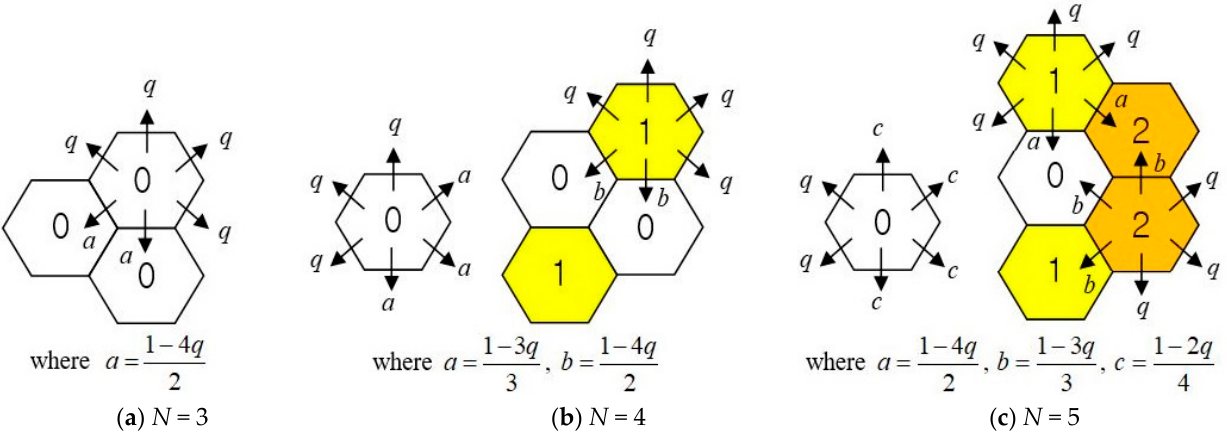
Figure 16. Revised random walk mobility model for ZBR [7].